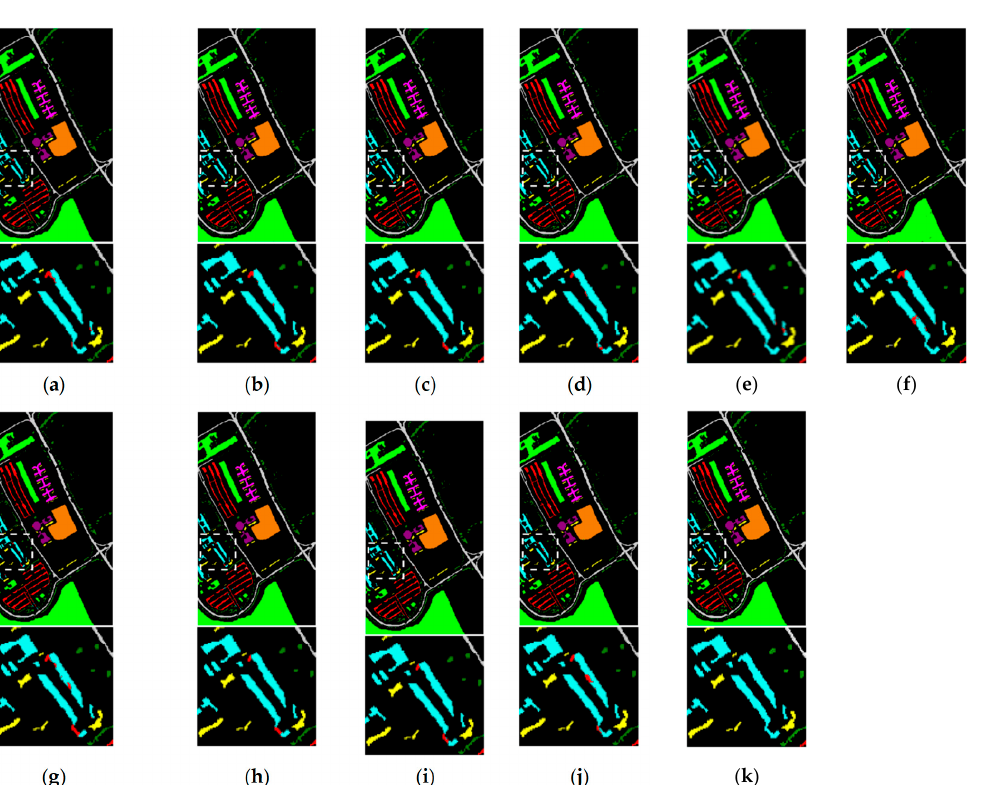
Figure 7. Classification maps generated by HybridSN using different BS methods for the Pavia dataset: ( a ) Full bands; ( b ) UBS; ( c ) OMP-BS; ( d ) PBS; ( e ) FNGBS; ( f ) SQ CCBSS; ( g ) LCMV-BSS; ( h )